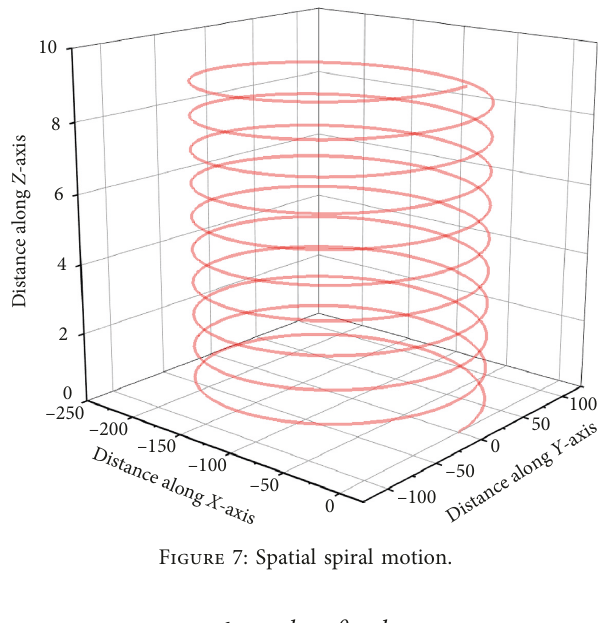
Figure 7: Spatial spiral